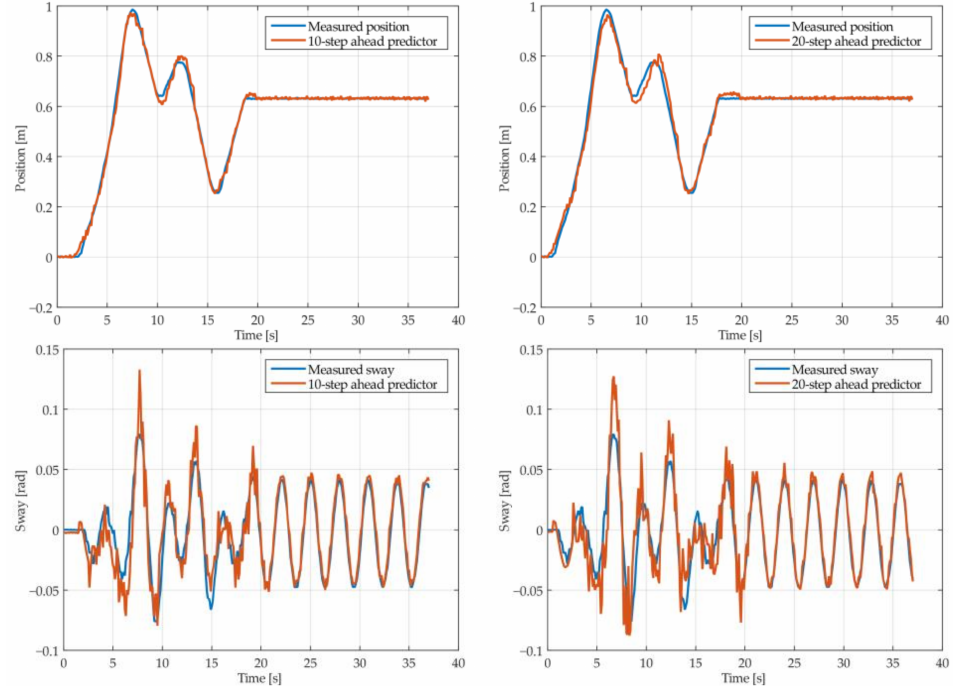
Figure 16. The 10- and 20-step ahead prediction with the MGGP model of the experimental crane position and payload sway with 1.7-meter rope length and 10 kg payload mass.